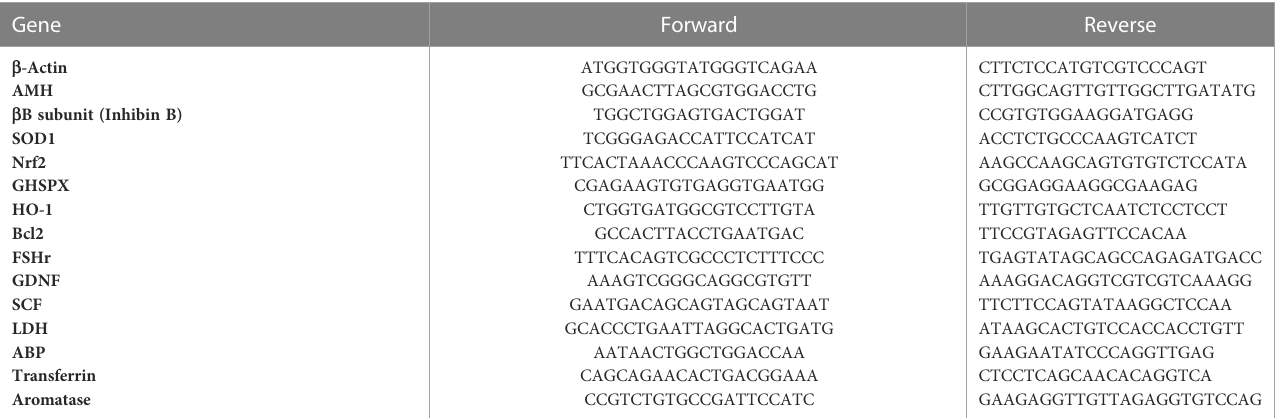
TABLE 1 Primer sequences for PCR